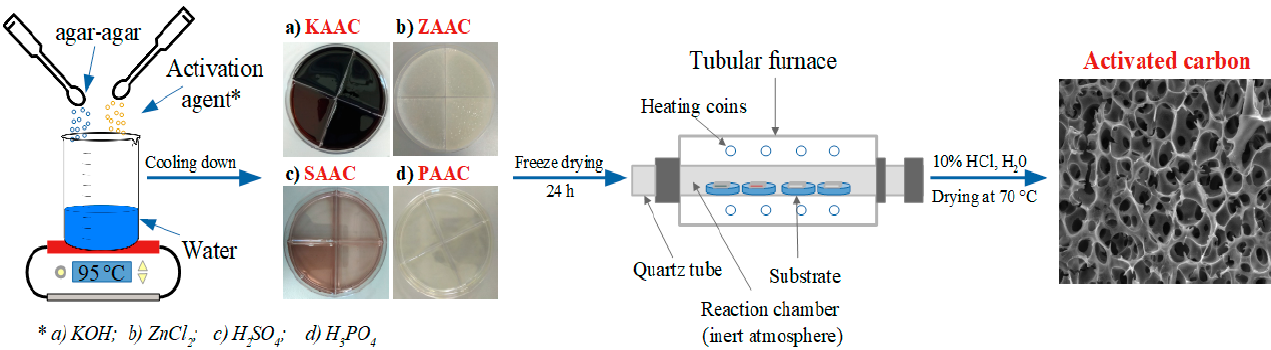
Scheme 1. Optimal temperature and time for preparation of AC from agar.